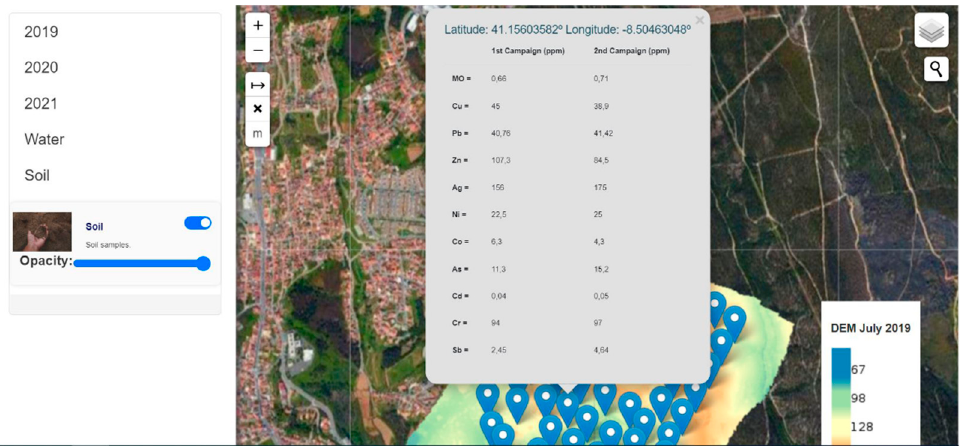
Figure 8. An excerpt of the webGIS with the representation of the table with the information on the hydrogeochemical and soil characterization on the webGIS.